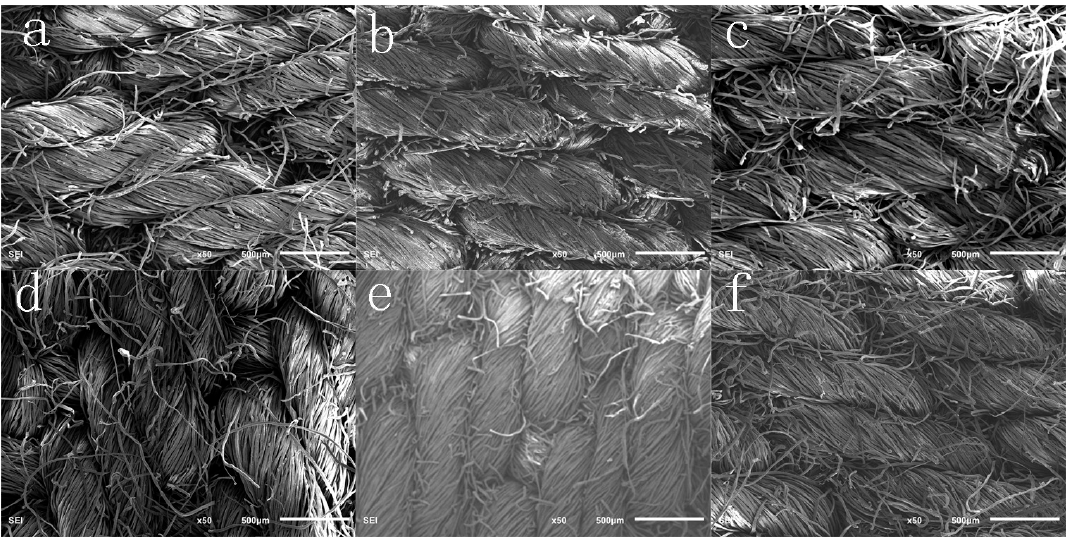
Figure 3. Scanning electron microscopy (SEM) pictures of different cotton samples (×50): a Desized, b Figure 4. Scanning electron microscopy (SEM) pictures of di ff erent cotton samples ( × 50): ( a ) Desized, laser bleaching, c enzyme bleaching, d sodium hypochlorite (NaClO) bleaching, e potassium ( b ) laser bleaching, ( c ) enzyme bleaching, ( d ) sodium hypochlorite (NaClO) bleaching, ( e ) potassium permanganate (KMnO 4 ) bleaching, ( f ) hydrogen peroxide (H 2 O 2 )